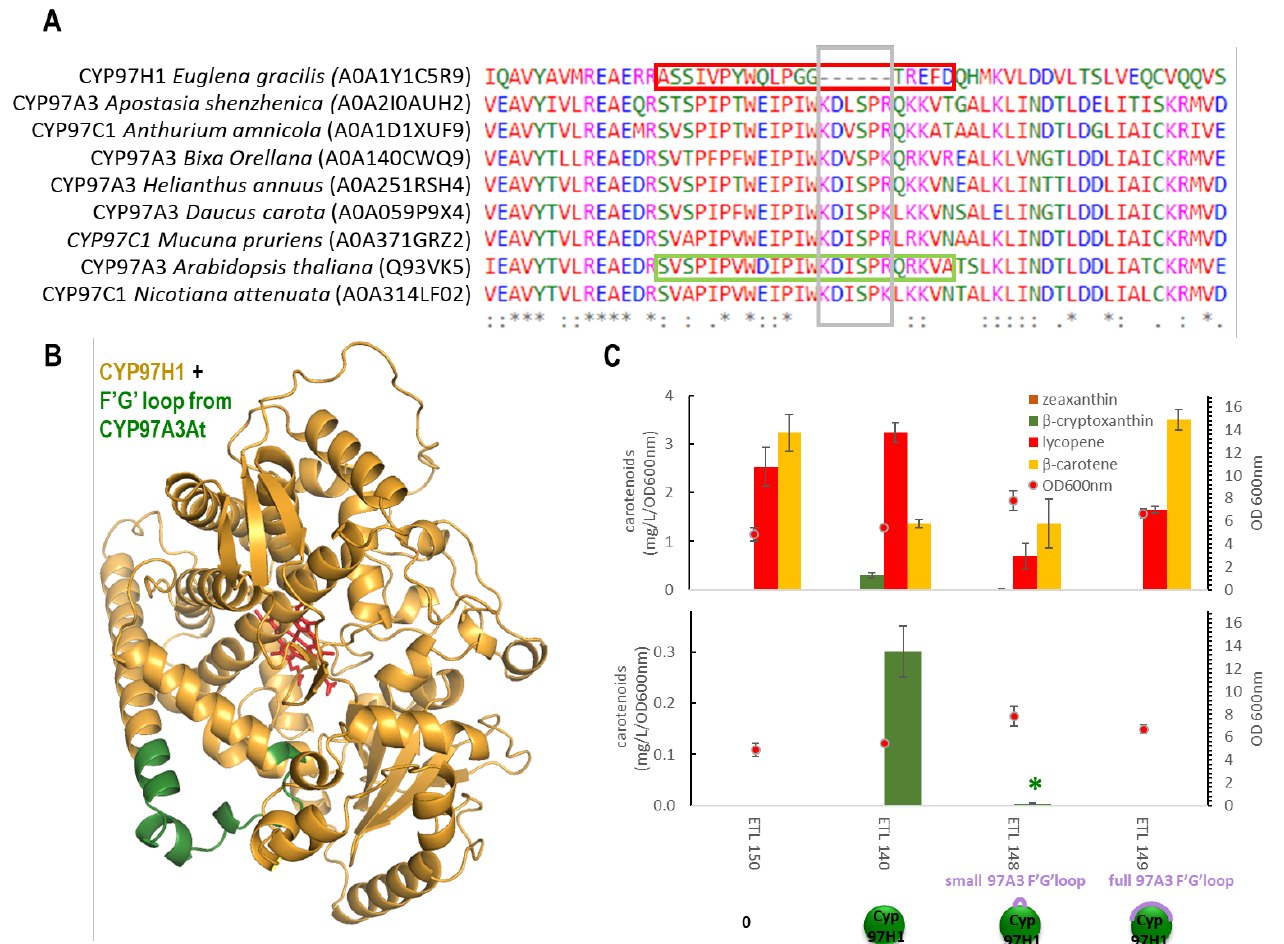
Figure 3. ( A ): CYP97 family alignment with a focus on the F′ - G′ region; species and sequence references were extracted from the Uniprot database. ( B ): Alphafold2 modelling of the chimera t CYP97H1 fullAt (CYP97H1 from E. gracilis is in gold, F′ - G′ loop from A. thaliana is in green, and the heme from CYP97A3 alignment is in red). ( C ): In vivo carotenoid production in the strains expressing F′ - G′ loop P450 chimeras.